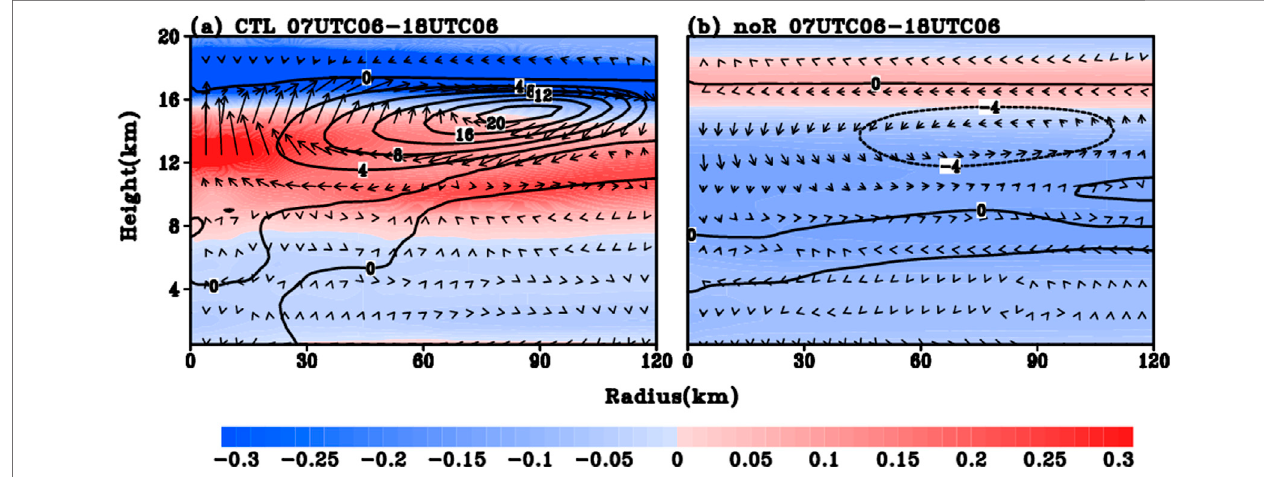
FIGURE 11 | The radius-height cross section of the averaged upper-level radiation (shaded; units: K/h), the forced transverse stream function (contour; units: m s − 1 ), and the associated secondary circulation (vector; units: m s − 1 ) from 07 UTC 6 to 18 UTC 6 August in (A) CTL and (B) noR, respectively.